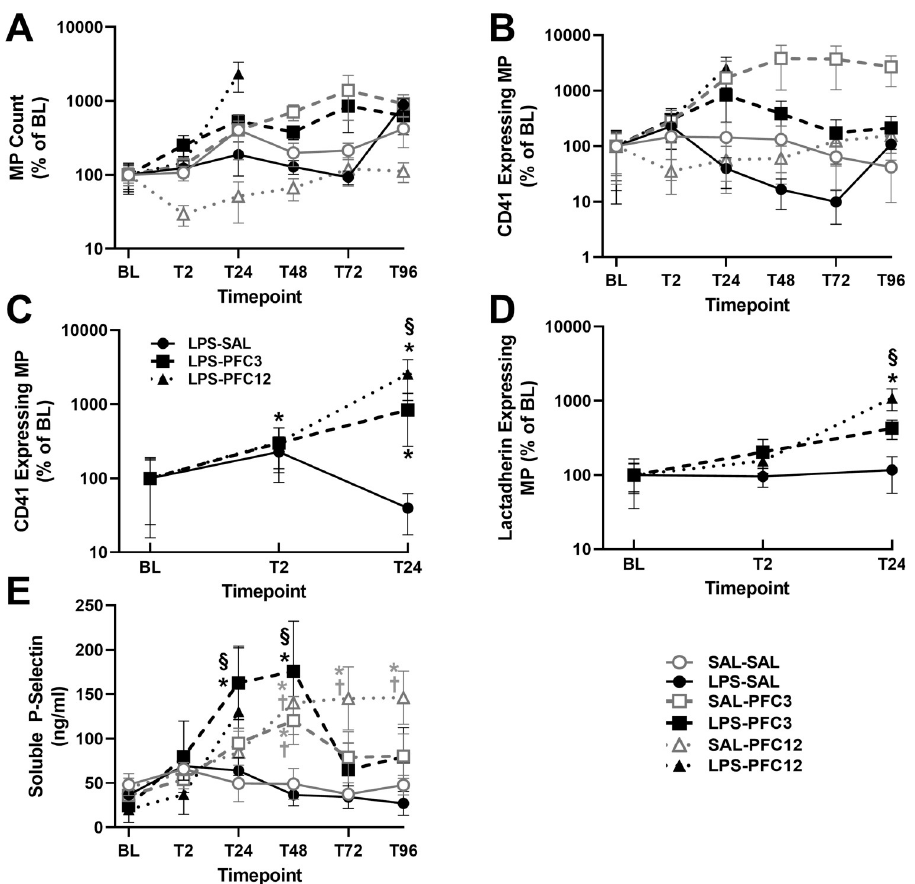
or time effects are seen. C. LPS 24h Subset of GIIb activated PLT MP. D. LPS 24h subset of lactadherin activated PLT MP. Graphs depict a log scale of increase over BL. E. Elisa of soluble P-selectin reveal LPS-PFC3 shows